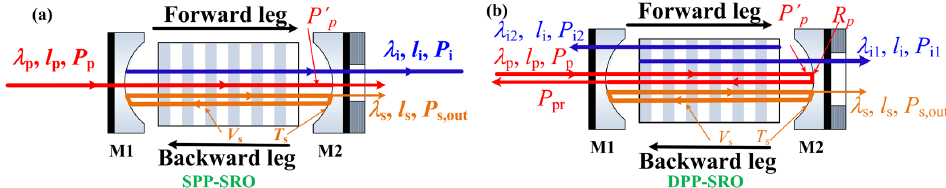
Figure 1. Schematic of the SROs under different pump schemes. ( a ) Single-pass pumping scheme, ( b ) Double-pass pumping scheme.